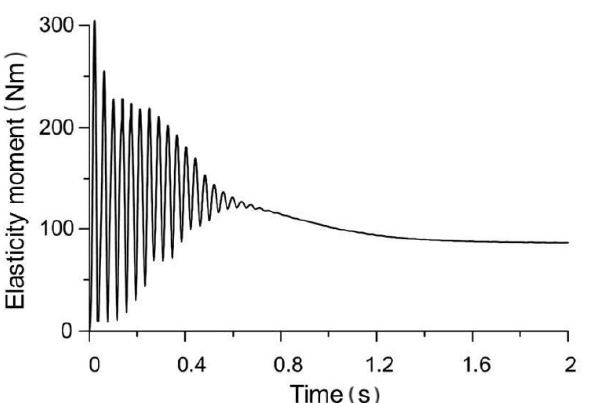
Figure 13. Results of numerical simulation of elasticity moment in a long-shaft drive transmission system.